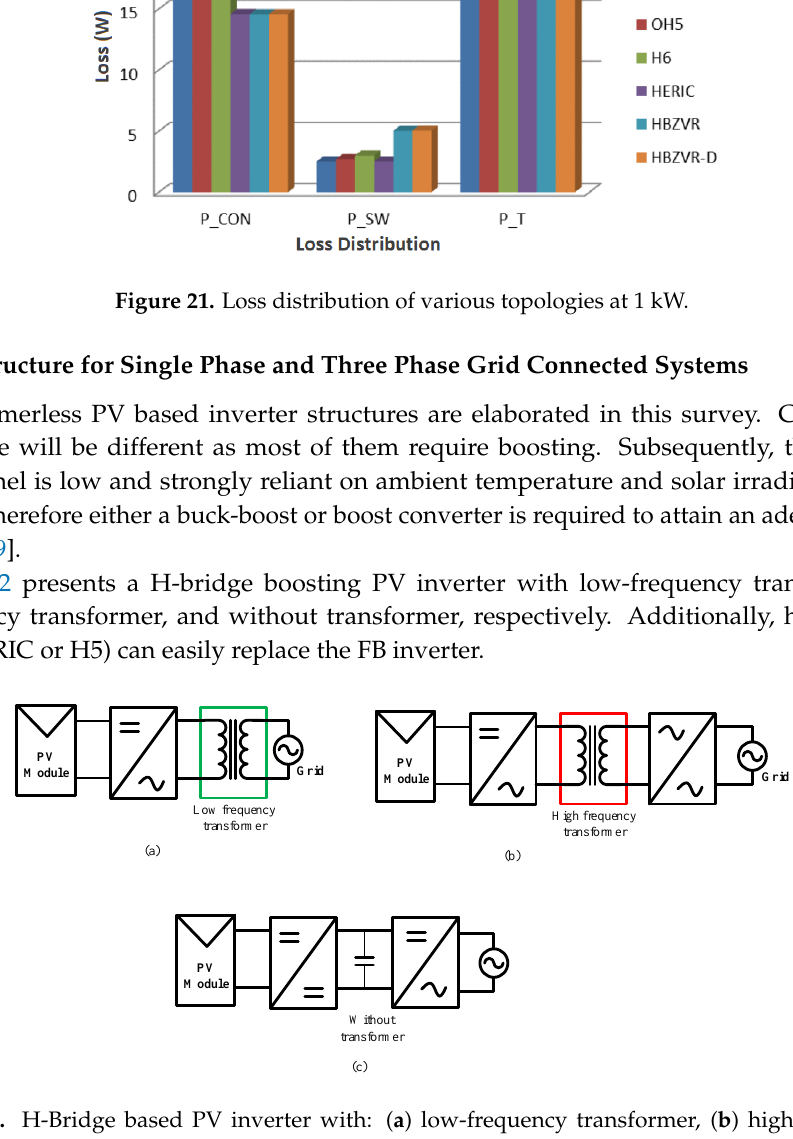
23 of 33 Table 3. Specification for loss calculation. Parameters for losses Simulation